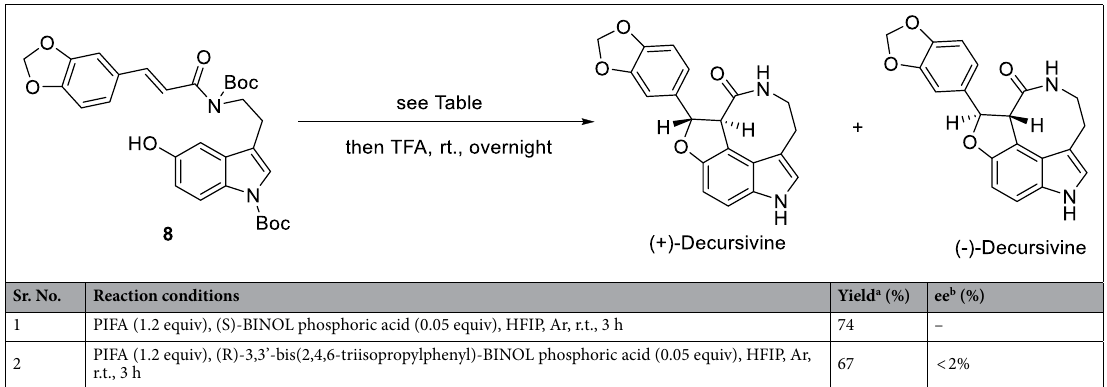
Table 3. Attempted asymmetric synthesis of decursivine using chiral BINOL phosphoric acid. a Isolated yield after column chromatography. b Determined by HPLC.